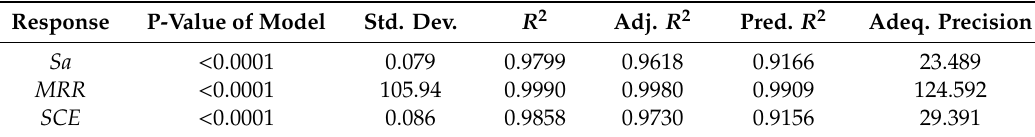
Table 5. Analysis of variance (ANOVA) for response variables.